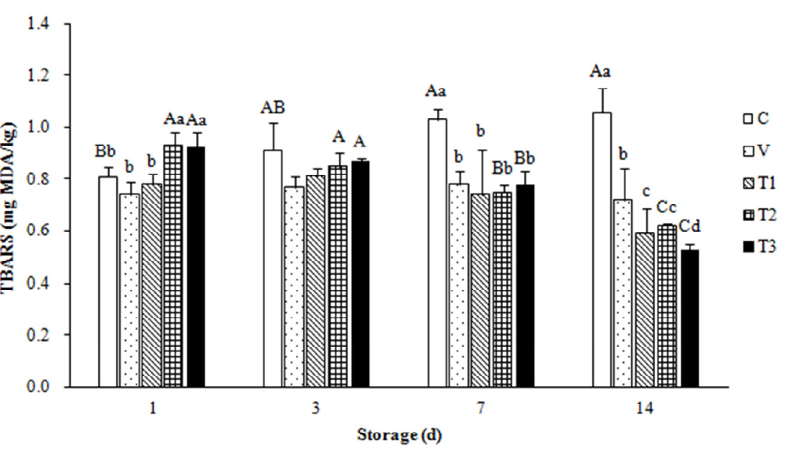
Figure 1. Thiobarbituric acid reactive substance (TBARS) values of fresh minced pork mixed with Viscum album L. (VAL) extract and subjected to refrigerated storage as described in Table 2. Values represent the mean of triplicate determinations. A-C Mean values± standard deviation (SD) with different letters for the same treatment during different storage periods are significantly different (p<0.01). a-d Mean values±SD with different letters for different treatments during the same storage period are significantly different